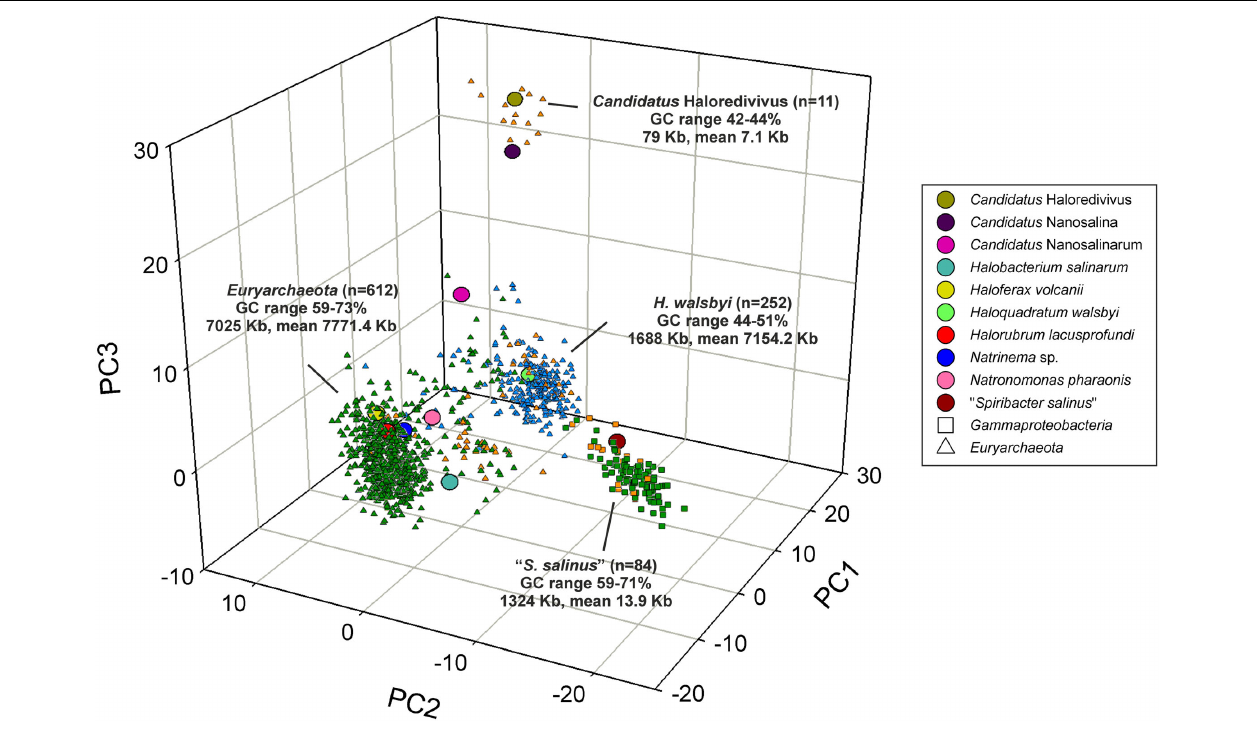
FIGURE 5 | Principal component analysis of tetranucleotide frequencies of assembled contigs from SS19, IC21, and SS33 datasets. Reference genomes are shown as larger circles. The following types of contigs are shown: orange: SS19 contigs, Green: